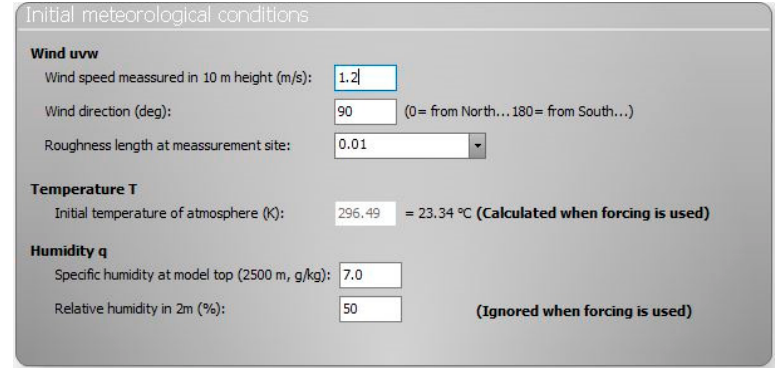
Figure 7. ENVI-met boundary conditions.